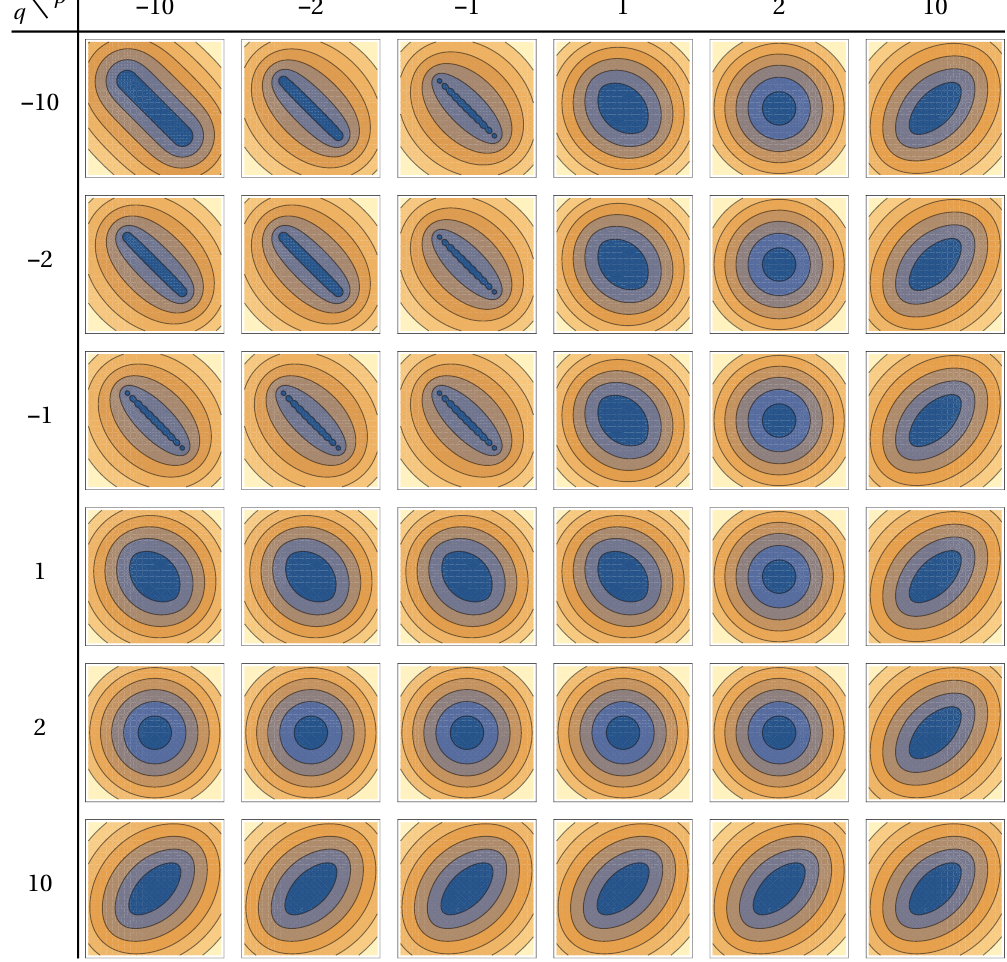
Figure 1. Table of ∆ p , q -neighborhoods of increasing radius around a discrete set of ten equidistant points along the line y = − x in R 2 , showing how their shape change for different values of p and q